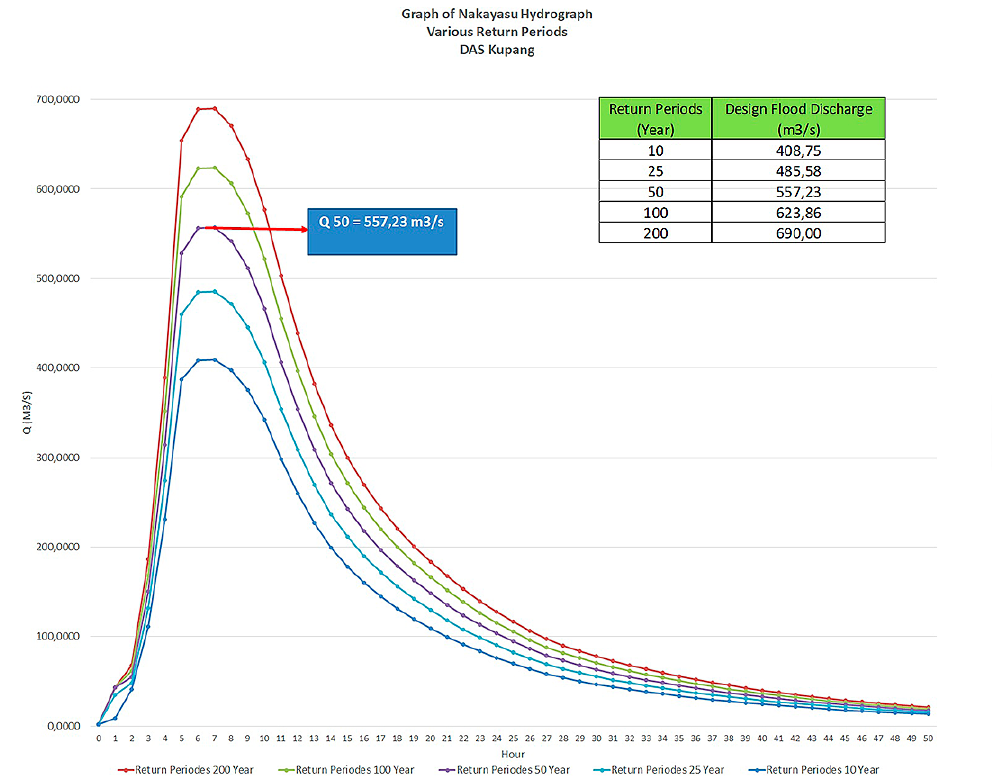
Figure 13. Flood Discharge Graph Planned Various Return